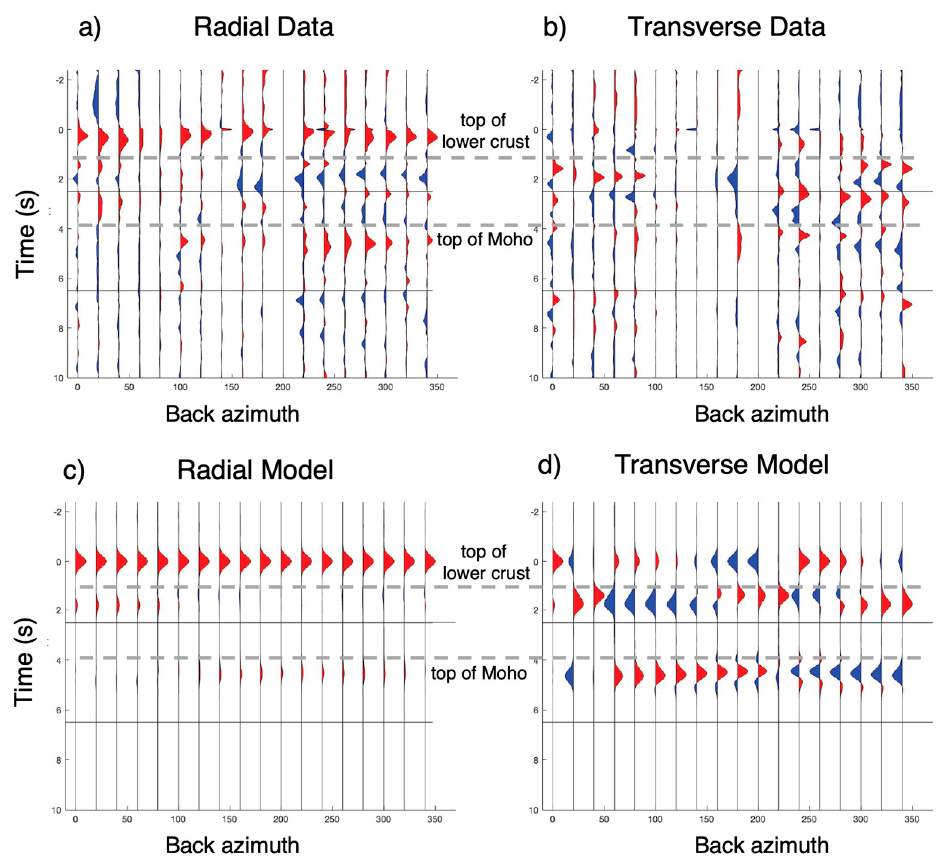
Figure 6. The radial and transverse receiver functions, binned by back azimuth, measured by the PLM station in southern California ( a , b ) and by the best-fitting model in the inversion ( c , d ); ( a , b ) the radial and transverse data; ( c , d ) the radial and transverse receiver functions from the best-fitting model. The horizontal solid, black lines indicate the four second Ps window, and the horizontal dashed gray lines represent the interpretations of the top of the lower crust and the Moho. The average zero-lag cross-correlation coefficient between corresponding traces is 0.81. Table 4. Full results from the best-fitting model for each of the twenty stations.